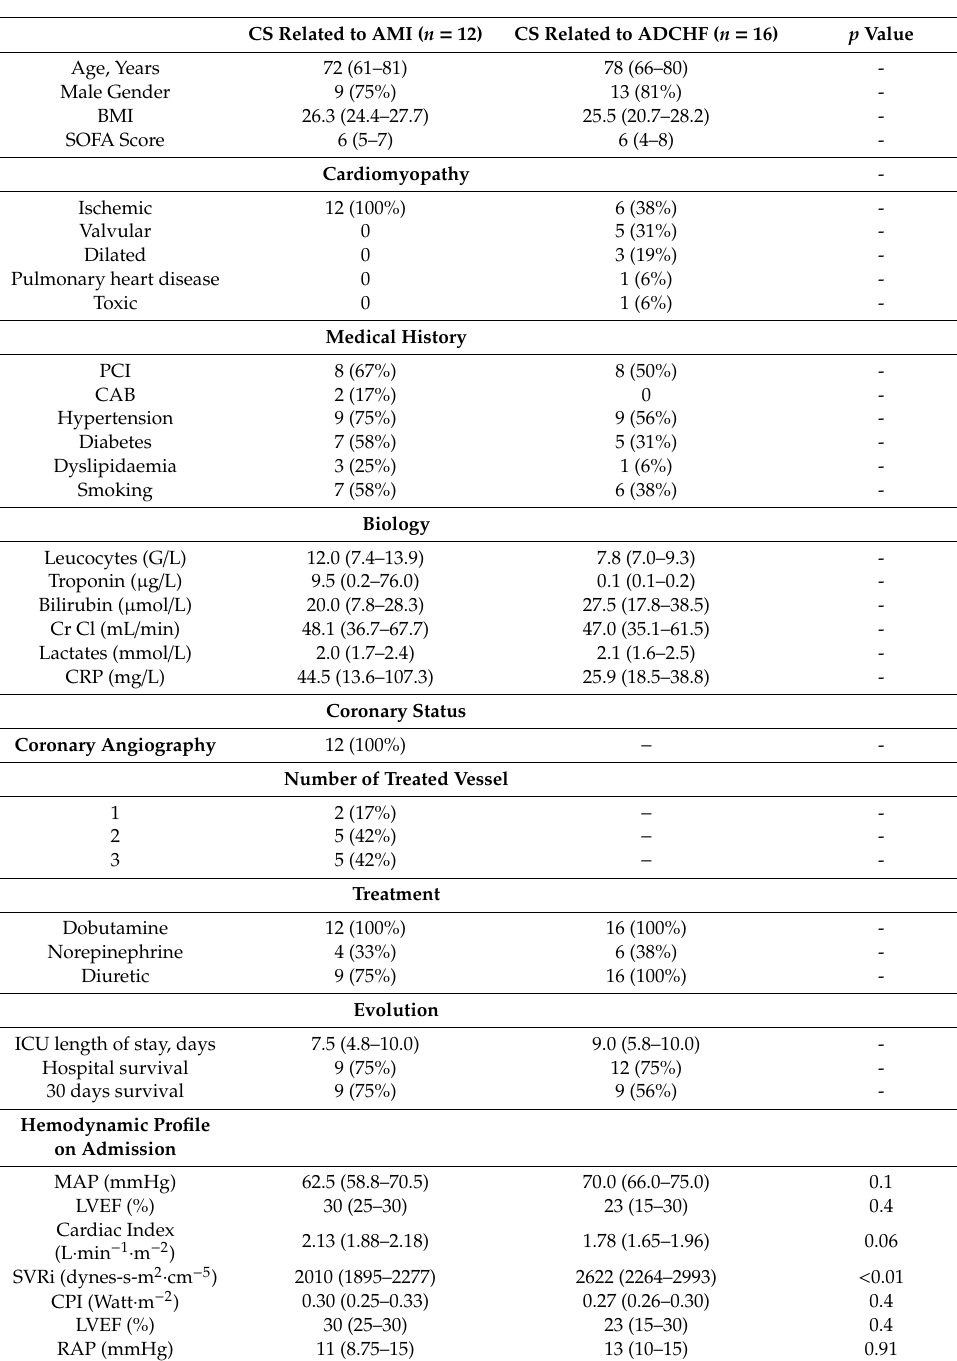
Table 1. Clinical, biological, and angiographic characteristics of the study population and hemodynamic profile on